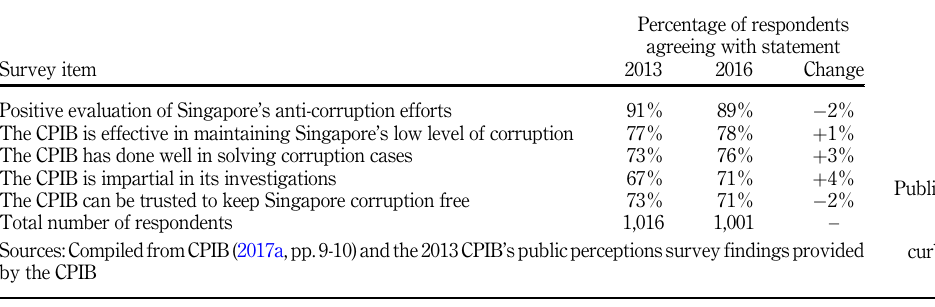
Table 2. Public perceptions